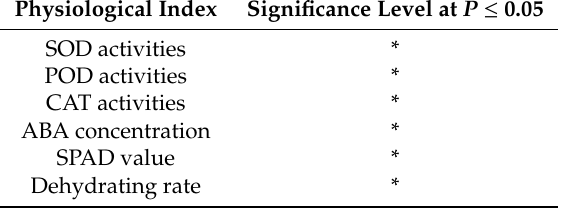
Figure 3. The superoxide dismutase (SOD), polyphenoloxidase (POD), and catalase (CAT) activities of husk leaf at days after silking (DAS) 12 ( A , D , G ), DAS 22 ( B , E , H ), and DAS 40 ( C , F , I ) of maize under two row directions (RD) and three plant spacings (PS) (EW and SN indicate row direction of east to west and south to north, respectively. SR indicates single rows spaced at 65 cm; WN1 indicates 40 cm twin rows spaced at 90 cm between the paired rows of narrow–wide rows; and WN2 indicates 40 cm twin rows, spaced at 160 cm between the paired rows of narrow–wide rows.). Bars denote the SE of the mean ( n = 3). Table 2. Out-put of one-way analysis of variance (ANOVA) for stages on superoxide dismutase (SOD), polyphenoloxidase (POD), and catalase (CAT) activities; abscisic acid (ABA) concentration; and SPAD value at days after silking (DAS )12, 22, and 40, as well as the dehydrating rate from DAS 12 to 22 and DAS 22 to